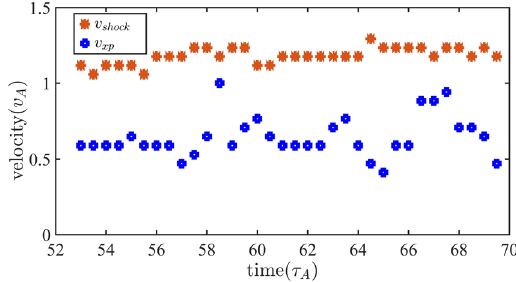
Figure 10. Velocities of Shock 1 and the X